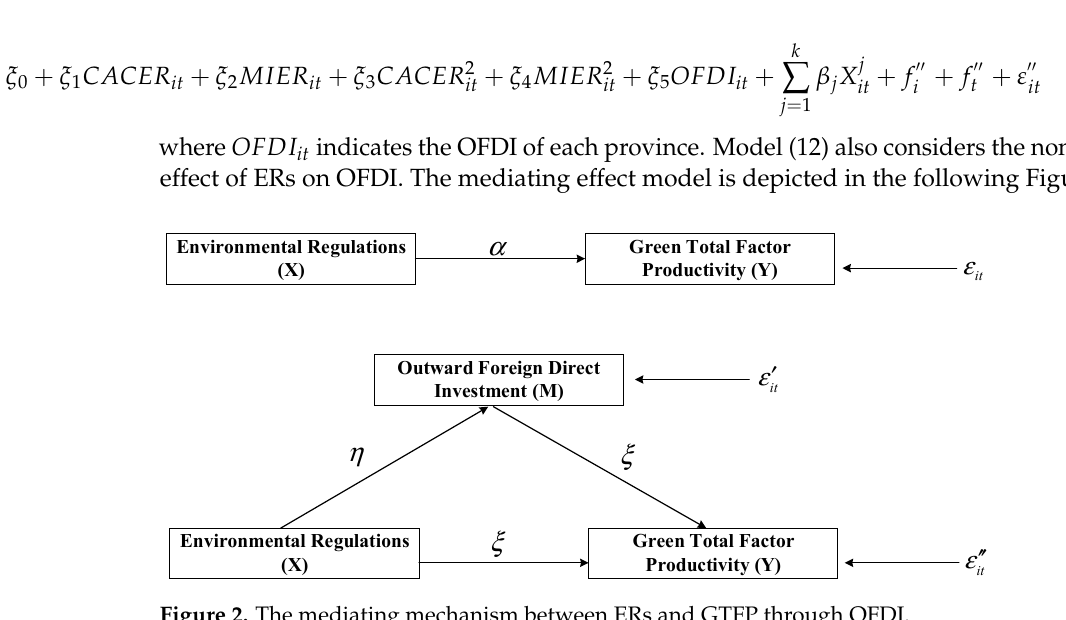
Figure 2. The mediating mechanism between ERs and GTFP through OFDI.